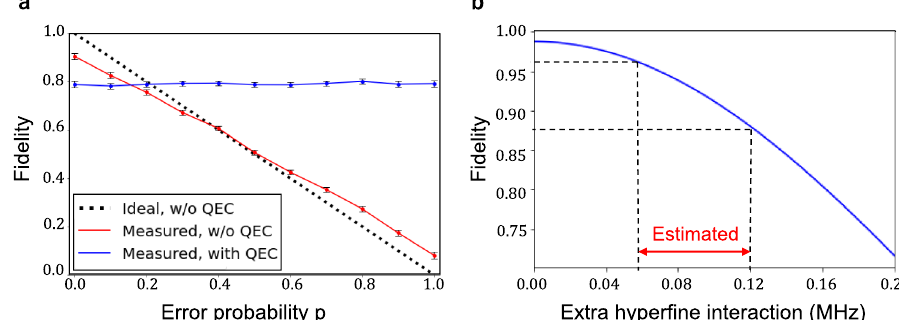
Fig. 4 Fidelity of QEC. a Dependence of the state fi delity of the nitrogen spin initialized to | + ⟩ N on the error probability. The blue (red) solid line is the experimental result of the fi delity obtained with (without: w/o) quantum error correction (QEC). The dotted line is the simulated fi delity without QEC. Because of the manipulation error in addition to the state preparation and measurement error, the fi delity without QEC is higher for p < 0.15, while the fi delity with QEC is higher for p > 0.15. Error bars are de fi ned as the standard deviation of the photon shot noise. b Estimated fi delity degradation of quantum encoding (decoding) operations as a function of the hyper fi ne coupling with another carbon that cannot be detected by optically detected magnetic resonance. The holonomic controlled-phase (C-Z) gate with the GRAPE-optimized pulse in the coding (decoding) operation is applied to a certain state, and the operational fi delity is simulated by the trace inner product between the generated state and the ideal state. Since the holonomic C-Z gate is optimized in the Hamiltonian with two carbons ( 13 C 1 , 1.14 MHz; 13 C 2 , 0.33 MHz), the presence of the third carbon degrades the operational fi delity.